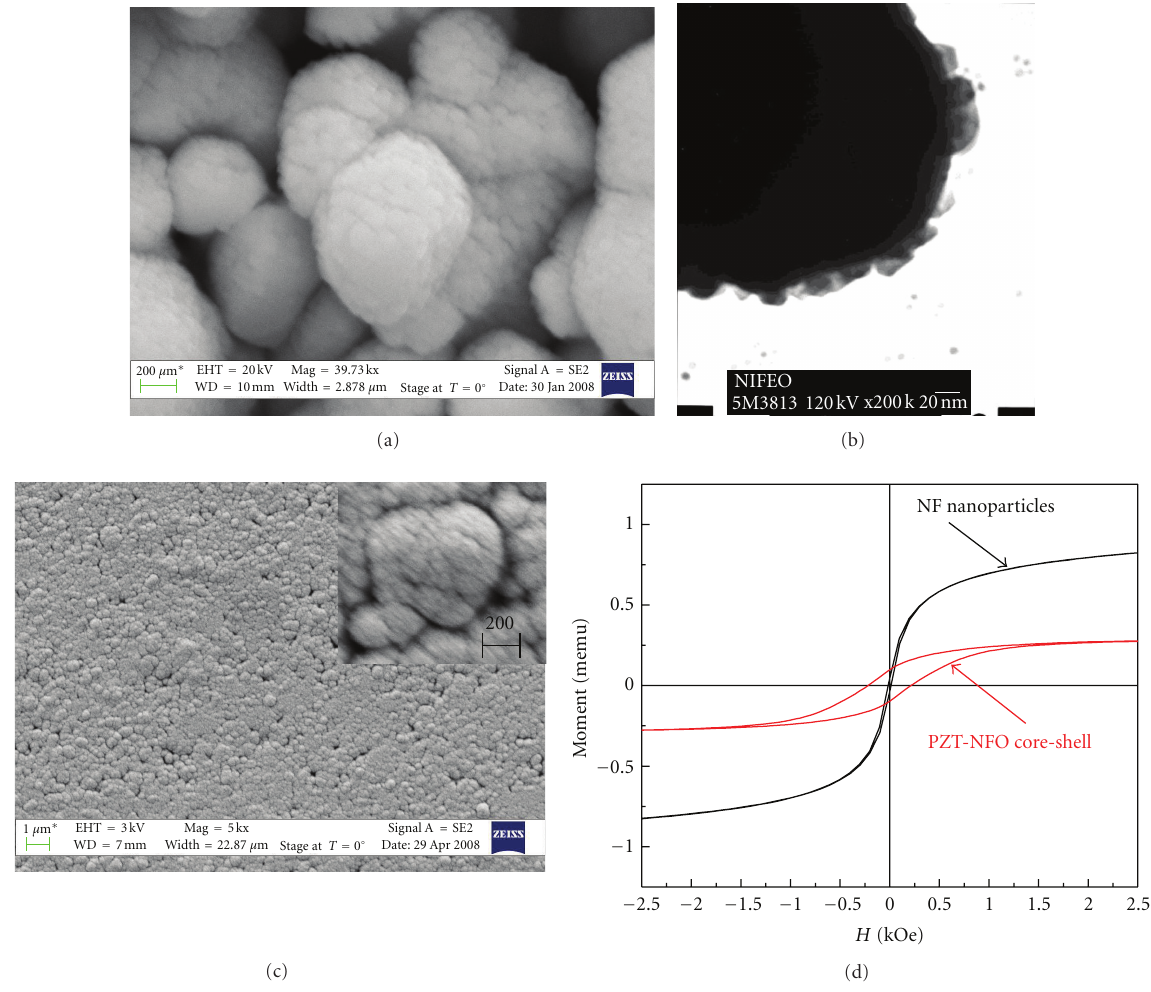
Figure 27: Micrographs for PZT-NF core-shell structure, (a) SEM and (b) TEM, (c) SEM microstructure of sintered PZT-NF core shell structure, and (d) comparison of magnetic hysteresis property of NF nanoparticles and PZT-NF core-shell